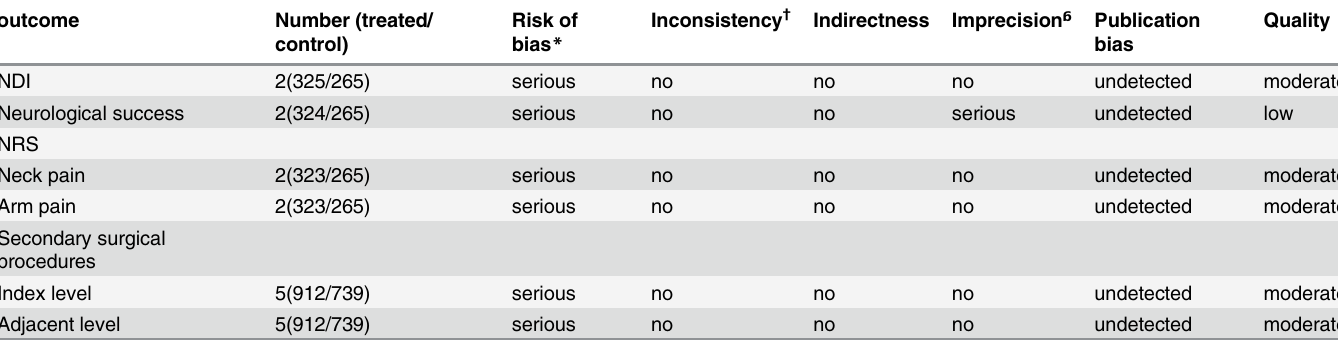
Table 4. GRADE evidence pro fi le of RCTs for compare CTDR and ACDF in midterm follow-up. outcome Number (treated/